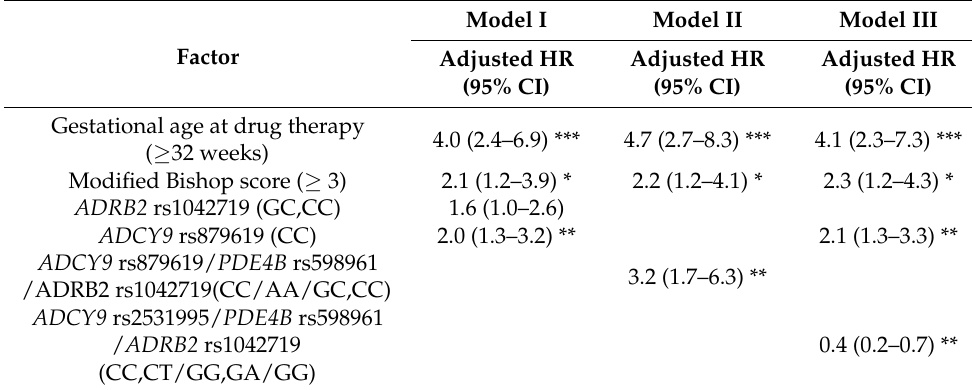
Table 3. Multivariable analysis of time to